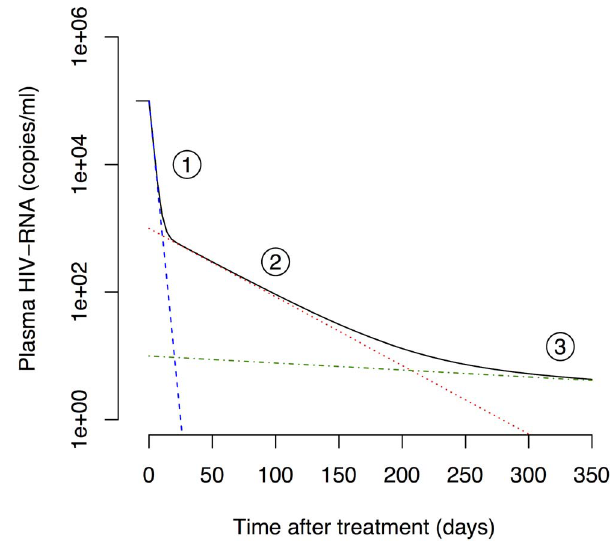
Figure 1. Three-phase decay of HIV-1 after start of cART. The black line shows a typical decay profile of plasma viral load during the first year of cART. Typical half-lives of the first (blue dashed line), second (red dotted line) and third phase (green dash-dotted line) are 1.5 days, 4 weeks and 39 weeks, respectively [22].